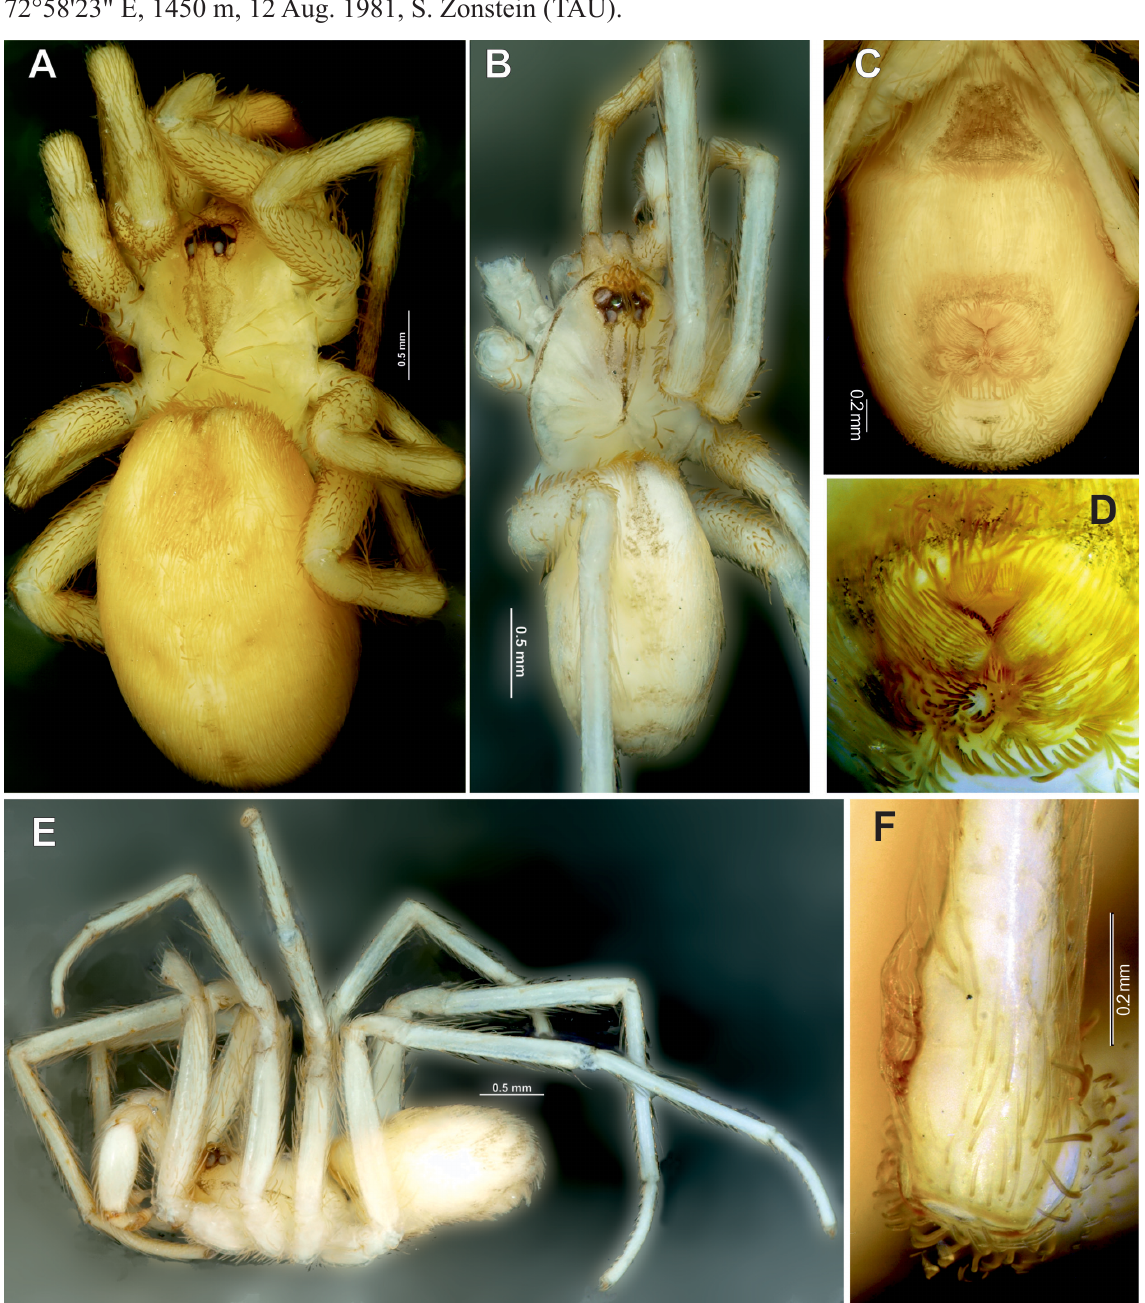
Fig. 31. Somatic characters of Zaitunia wunderlichi sp. nov., paratype, ♀ ( A , C–D , F ), paratype ( B ), ♂ and holotype ( E ), ♂. — A – B . Habitus, dorsal. C . abdomen, ventral. D . Spinnerets, ventral. E . Habitus, lateral. F . Calamistrum,